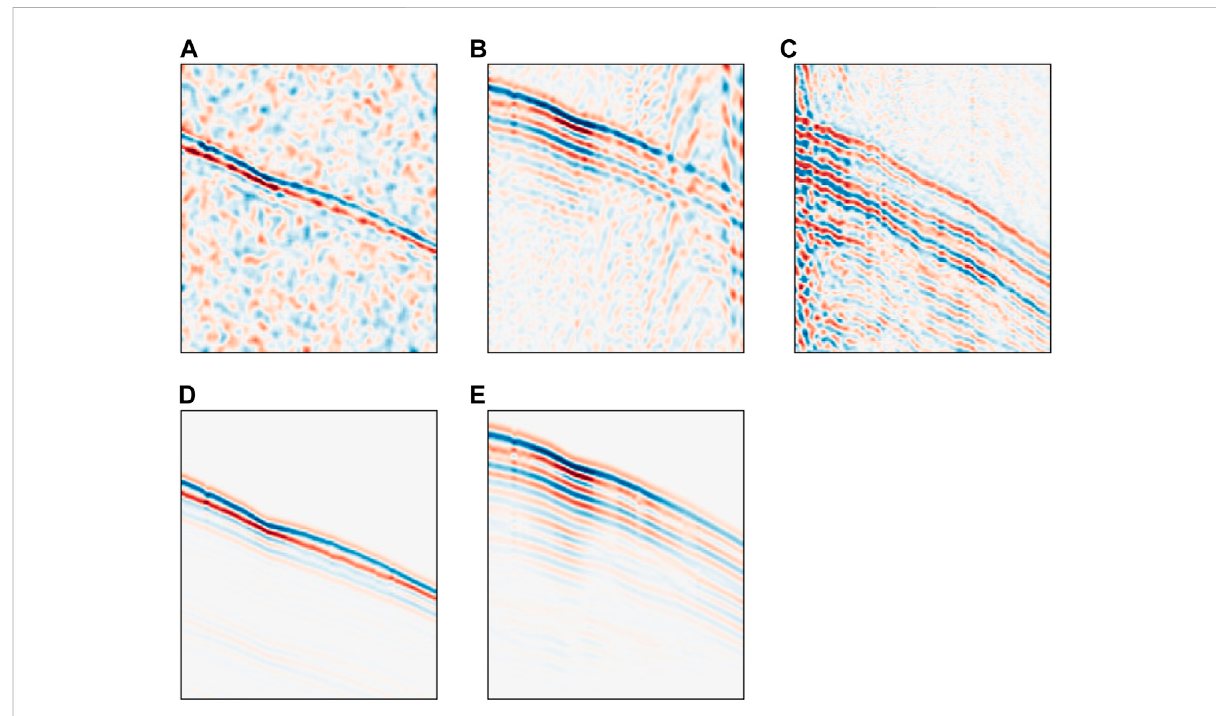
FIGURE 4 Microseismic events from synthetic (A) and (D) , semi-synthetic (B) and (E) and fi eld data (C) . Top row illustrates the data to be denoised, whilst the bottom row illustrates the noise-free target data (i.e., the generated